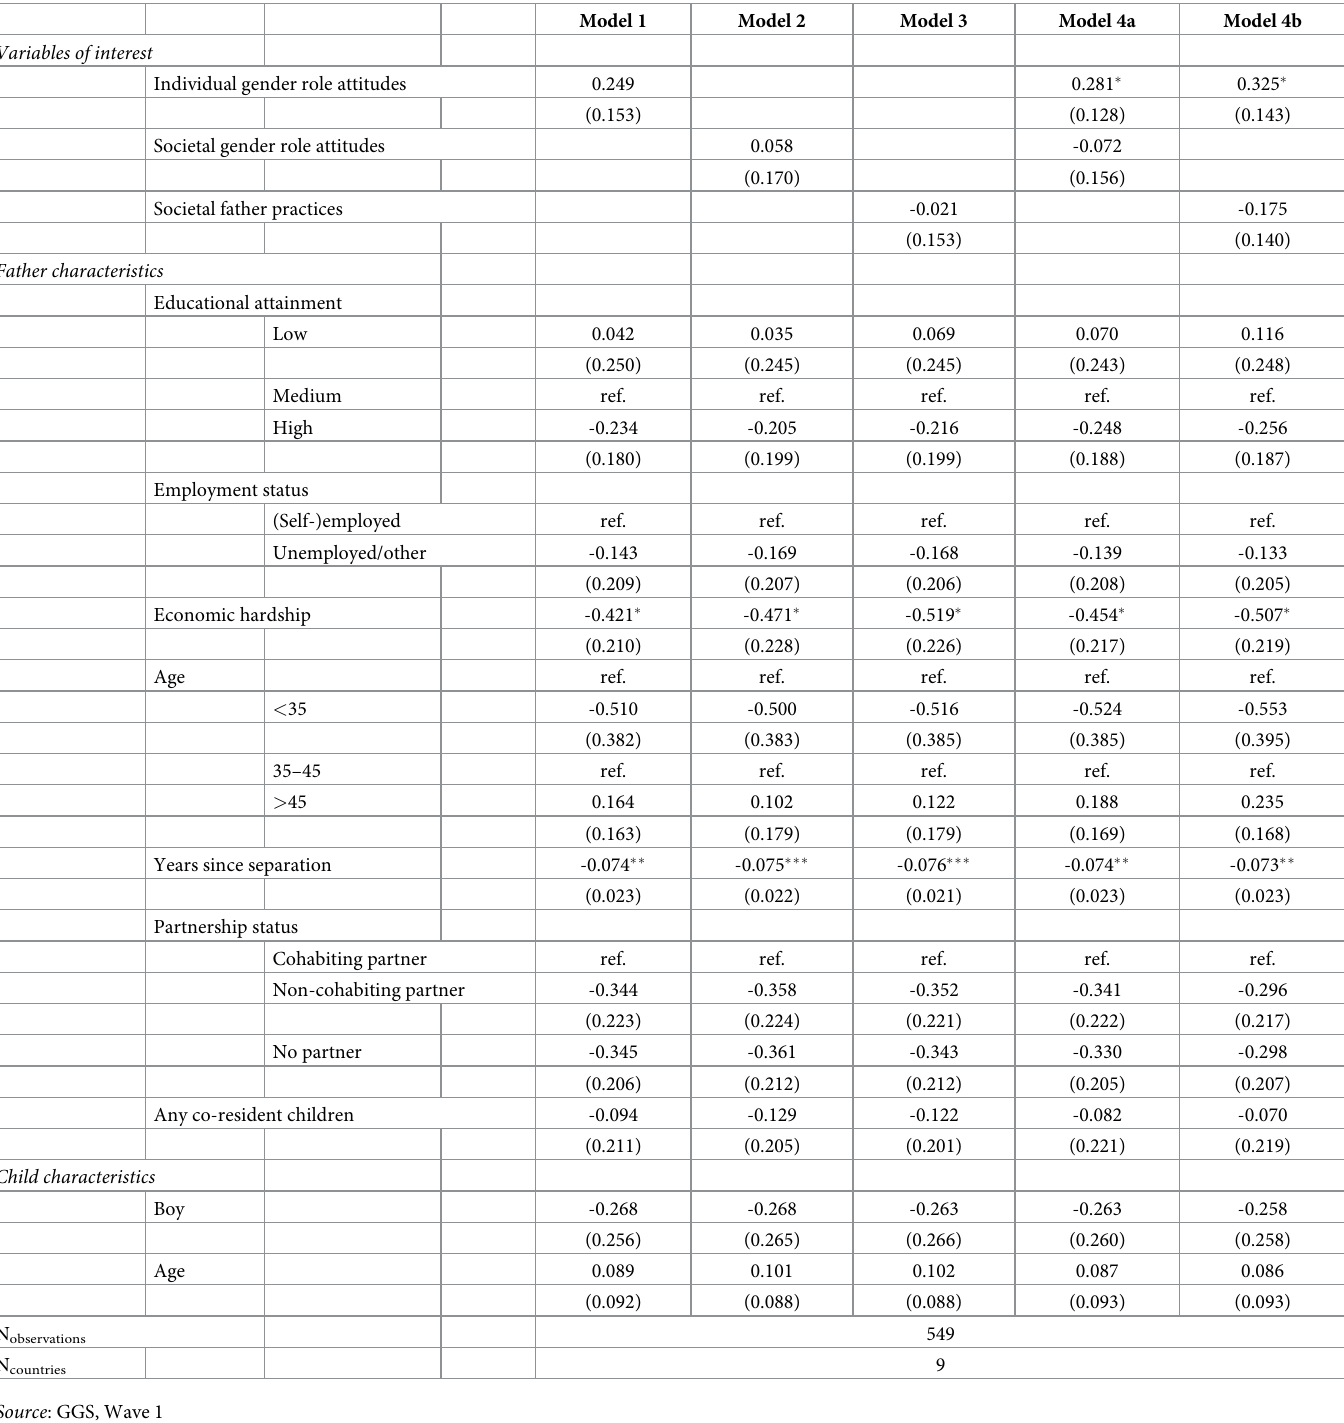
Table 6. Average marginal effects from the logistic regression predicting monthly nonresident father-child contact for the adolescent-sample (reference: no monthly